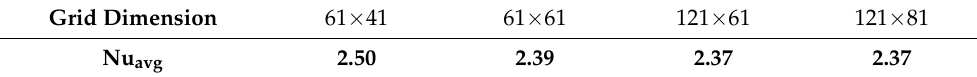
Table 3. Average Nusselt number for eccentric state with several axial grid number for RR = 0.5. Grid Dimension